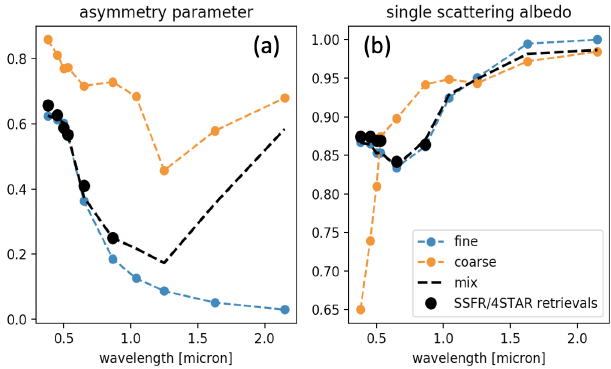
Figure B1. Mie calculations of (a) g and (b) SSA compared to SSFR/4STAR-retrieved values. The black dots show the asym- metry parameter spectrum (left) and SSA spectrum (right) as re- trieved from SSFR/4STAR; the blue dot-dash line shows a fine- mode aerosol ( r = 0.13nm) with a real index of refraction of 1.6 and an imaginary index of refraction ranging from 0.05 (380nm) to 0 (2nm); the orange dot-dash line shows a coarse-mode aerosol ( r = 1.3nm) with the real index of refraction of 1.6 and an imag- inary index of refraction ranging from 0.015 (380nm) to 0.003 (600nm) (Wagner et al., 2012). The black line shows a mix of coarse/fine aerosol (0.02:2 optical thickness